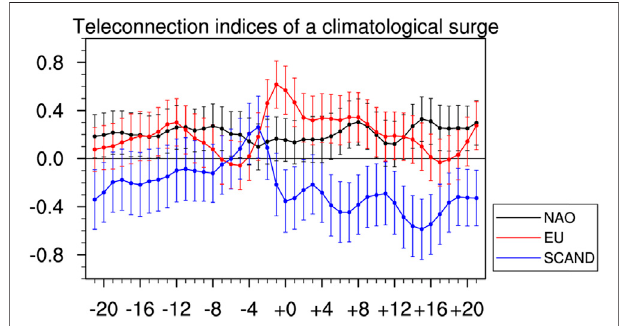
FIGURE 4 | Daily time-series of normalized NAO, EU and SCAND indices from day-21 to day +21 of a climatological cold surge, where the error bars indicate the 95% con fi dence interval of the teleconnection indices derived from the standard error across the 344 cold